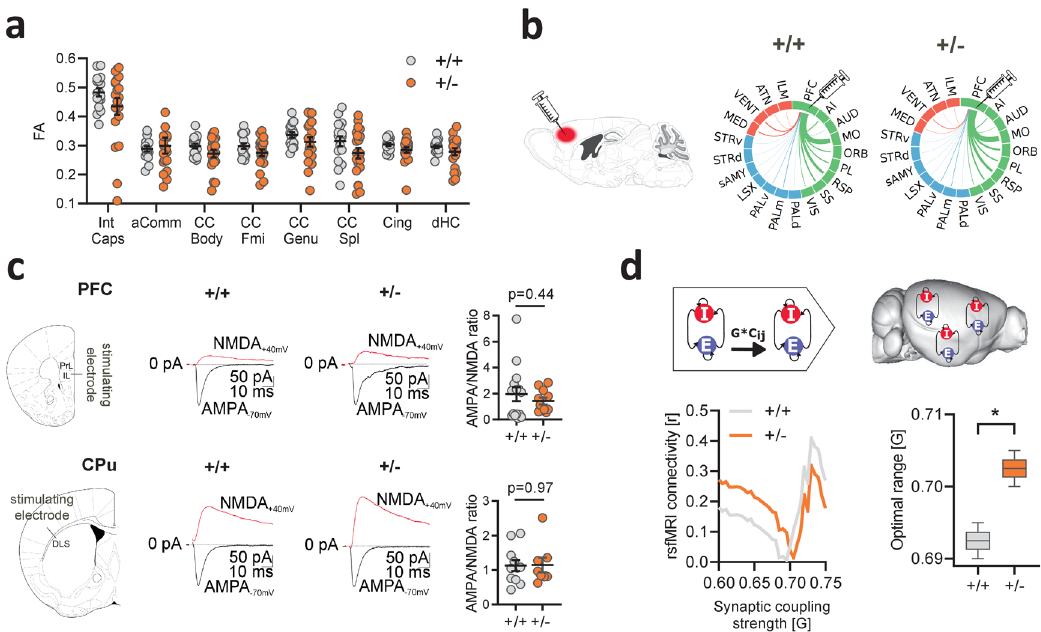
Fig. 2 Increased synaptic coupling explains functional hyperconnectivity in Tsc2 + / − mice. a Fractional anisotropy (FA) quanti fi cation in the anterior commissure, corpus callosum, cingulate, dorsal hippocampus, and internal capsule as assessed with diffusion-weighted imaging. Intergroup comparisons showed preserved FA in Tsc2 + / − mutant mice with respect to control littermates. Int Caps internal capsule, aComm anterior commissure, CC Body body of the corpus callosum, CC Fmi forcep minor of the corpus callosum, CC Genu genu of the corpus callosum, CC Spl splenium of the corpus callosum, Cing cingulum, dHC dorsal hippocampus. n = 20 mice for each group. Error bars represent SEM. b Regional quanti fi cation of retrogradely labeled cells as probed with the injection of recombinant rabies virus in the prefrontal cortex. The thickness of the links in the circular layouts is proportional to the relative number of labeled cells. Cortical areas are depicted in green, subcortical regions in blue, and thalamic areas in red. No differences were observed between in Tsc2 + / − and Tsc2 + / + mice in any of the examined regions. PFC prefrontal cortex, AI agranular insular cortex, AUD auditory cortex, MO motor cortex, ORB orbitofrontal cortex, PL prelimbic cortex, RSP retrosplenial cortex, SS somatosensory cortex, VIS visual cortex, PALd globus pallidus (dorsal part), PALm globus pallidus (medial part), PALv globus pallidus (ventral part), LSX lateral septal complex, sAMY striatum-like amygdalar nuclei, STRd striatum (dorsal part), STRv striatum (ventral part), MED medial thalamus, VENT ventral thalamus, ATN anterior thalamus, ILM intralaminar thalamus. c Intracellular electrophysiological recordings in prefrontal and striatal neurons of Tsc2 + / − mutant and control mice. Intergroup comparisons revealed comparable AMPA/NMDA ratio in Tsc2 + / − and Tsc2 + / + mice in both the regions probed (PFC, unpaired t test, two-sided, t = 0.79, P = 0.44; CPu, unpaired t test, two-sided, t = 0.07, P = 0.97). PFC prefrontal cortex, PrL prelimbic, IL infralimbic, CPu striatum, DLS dorsolateral striatum. PFC, n = 15 mice ( + / + ), n = 11 mice ( + / − ); CPu, n = 11 mice ( + / + ), n = 8 mice ( + / − ). Error bars represent SEM. d Whole-brain network modeling 44 was carried out to probe a putative mechanistic link between interareal coupling strength (G) to empirical measurements of whole-brain rsfMRI connectivity (left). Optimal G was selected on the basis of the minimal difference between modeled and empirical rsfMRI connectivity ( y axis) for both genotypes (middle). Intergroup differences (permutation-based unpaired t-test, two-sided, G diff = 0.010, P = 0.030) revealed higher optimal G in Tsc2 + / − vs. control mice (right). n = 20 mice for each group. Box and whiskers: Tsc2 + / + , min = 0.6900, max = 0.6950, centre = 0.6925, bounds of box and whiskers = 0.6912 – 0.6933, quartiles; Tsc2 + / − , min = 0.7000, max = 0.7050, centre = 0.7025, bounds of box and whiskers = 0.7012 – 0.7033, quartiles. * P < 0.05. Source data are provided as a Source Data fi